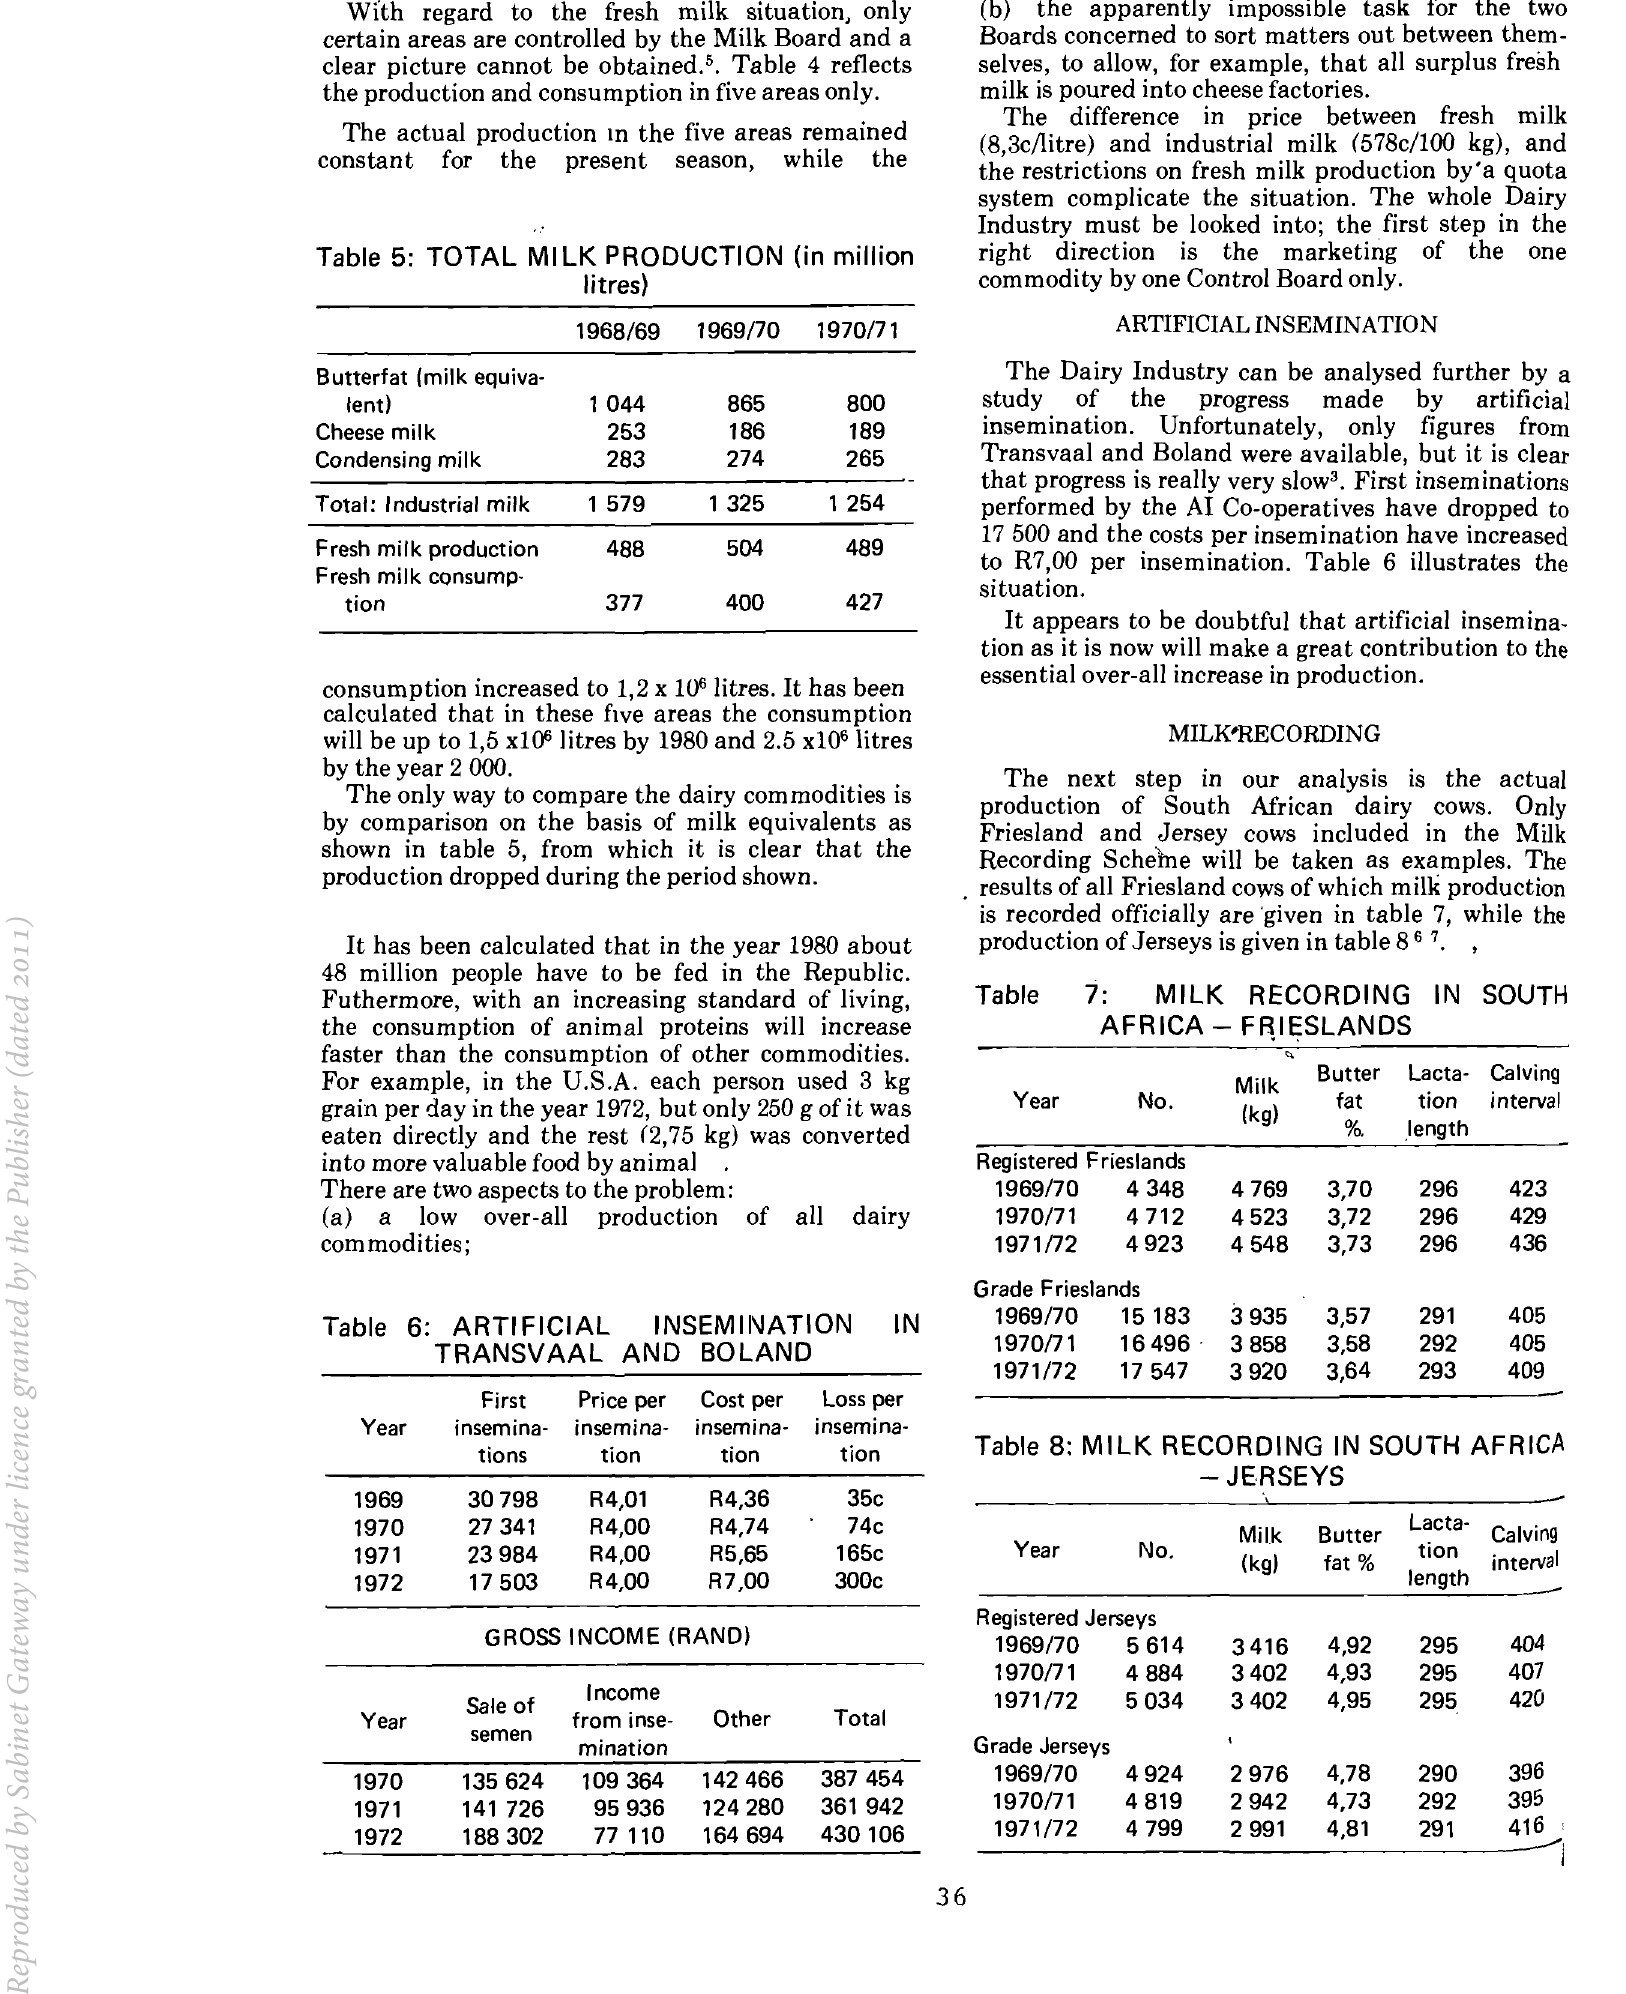
Table 5: TOTAL MILK PRODUCTION (in million